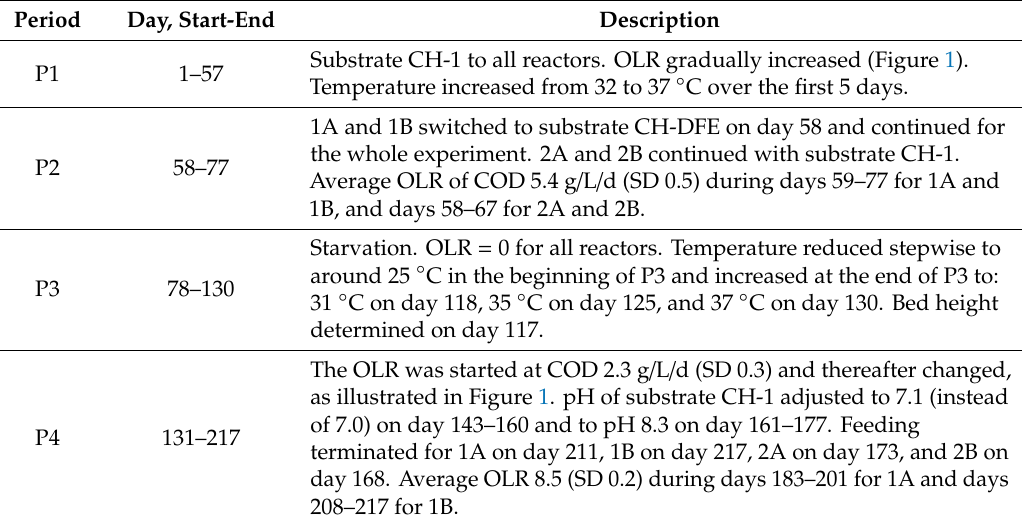
Table 1. Description of operating periods of upflow anaerobic sludge blanket (UASB)